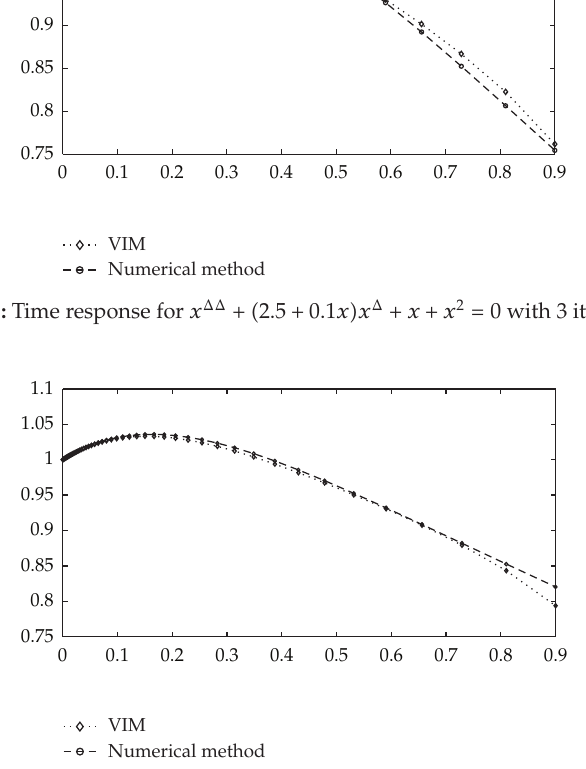
Figure 4: Time response for x ΔΔ (cid:10) (cid:7) 2 . 5 (cid:10) 2 . 5 x (cid:8) x Δ (cid:10) x (cid:10) x 2 (cid:6) 0 with 7